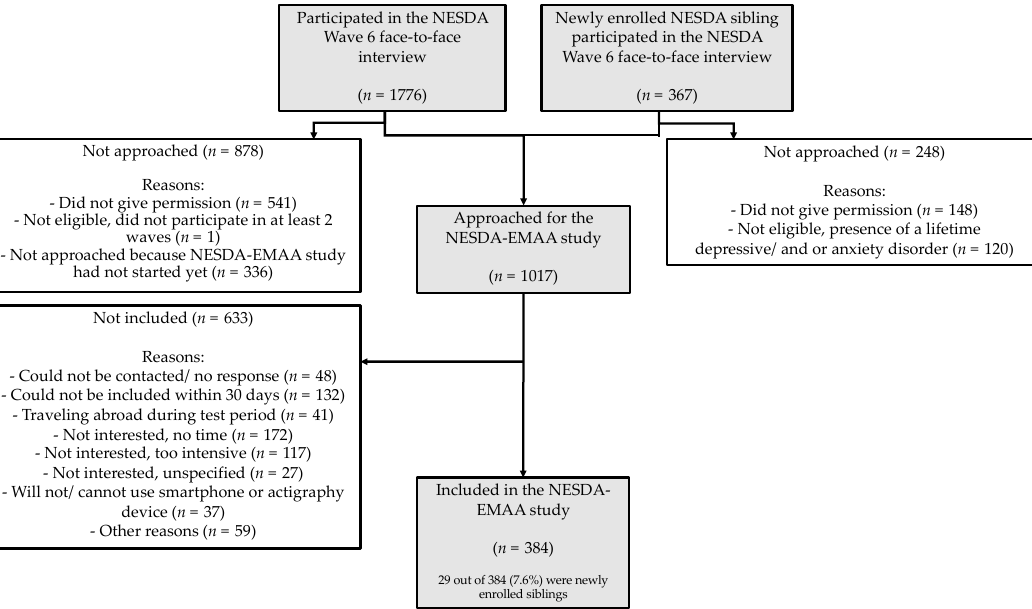
Figure 1. Flowchart of the Ecological Momentary Assessment (EMA) and Actigraphy sub-study (NESDA-EMAA).